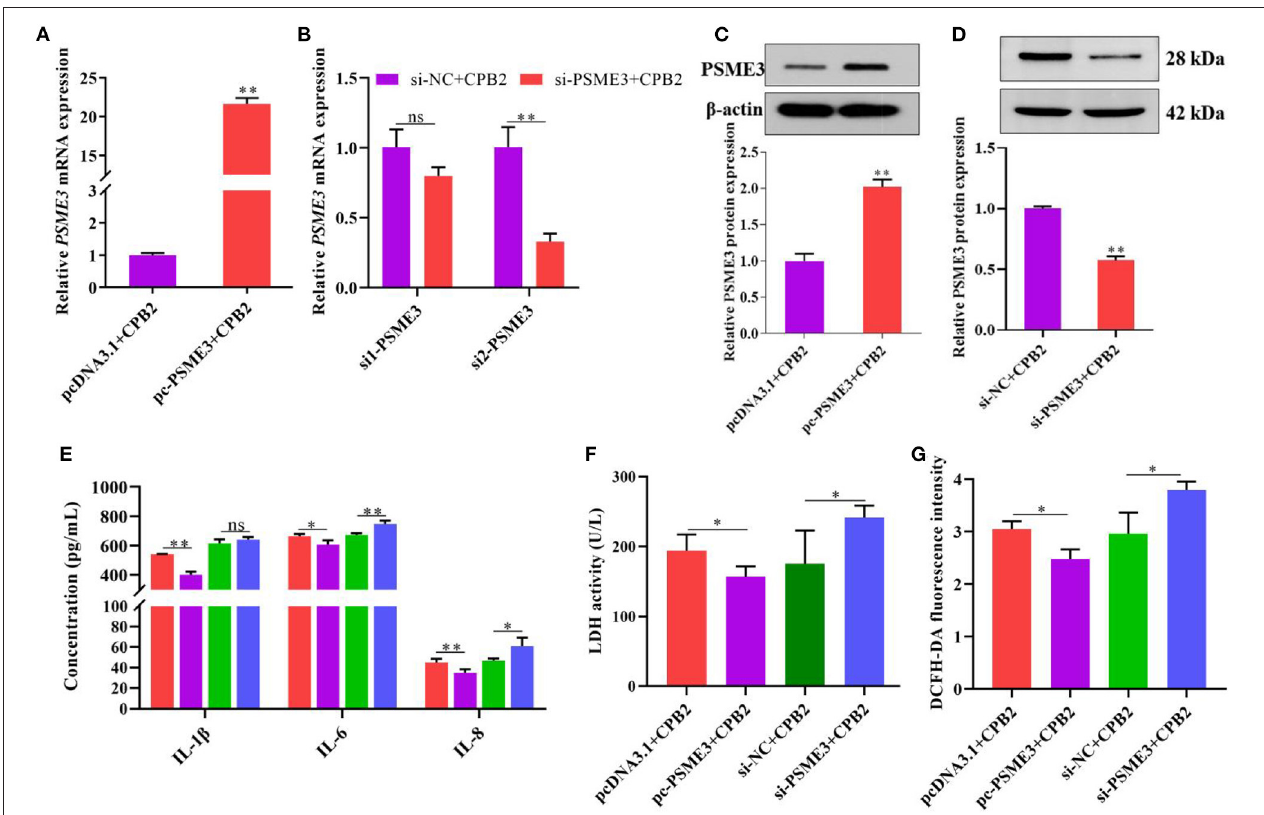
FIGURE 5 | PSME3 repressed CPB2 toxin-induced inflammation in IPEC-J2 cells. The IPEC-J2 cells were transfected with pcDNA3.1, pc-PSME3 (1 µ g), si-NC, and si-PSME3 (150nM), and treated with CPB2 toxin. (A,B) qPCR analysis of PSME3 expression after transfection of pcDNA3.1, pc-PSME3 (1 µ g), si-NC, si1-PSME3, and si2-PSME3 (150nM). (C,D) Western blot analysis of PSME3 expression after transfection of pcDNA3.1, pc-PSME3 (1 µ g), si-NC, and si2-PSME3 (si-PSME3, 150nM). (E) ELISA analysis of IL-1 β , IL-6, and IL-8 expression. (F) LDH activity was tested at 450nm in a microplate reader. (G) The ROS level was tested by microplate reader at 488-nm excitation wavelength and 535-nm emission wavelength. ns: not significant, * p < 0.05, ** p <